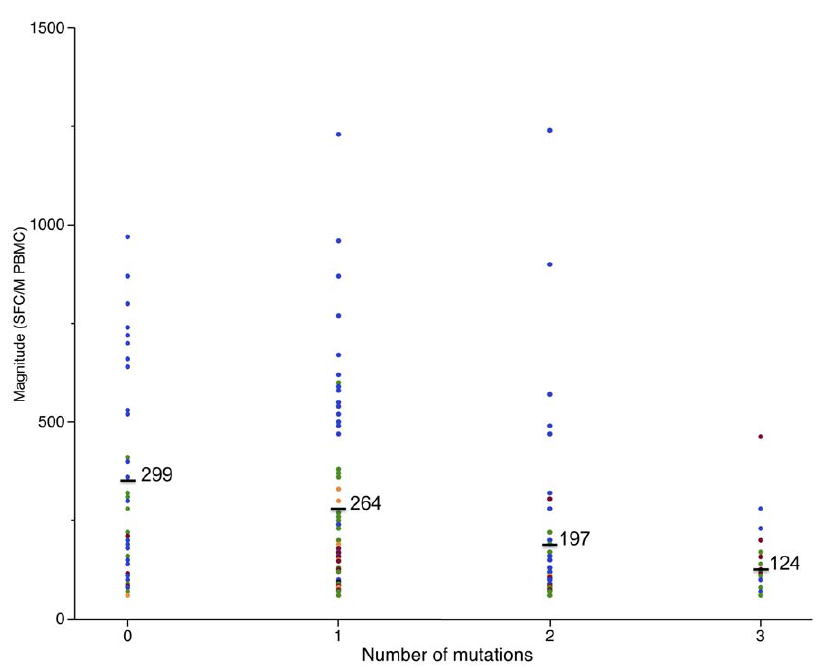
Figure 5. Magnitude of IFN- c ELISpot responses toward peptides that do or do not match each individual’s HIV-1 sequence. The graph shows the magnitude of ELISpot responses as a function of the number of mutations between the peptide tested and the individual’s autologous HIV-1 consensus sequence. This analysis was performed for the five individuals in our cohort from whom HIV-1 sequences were available.